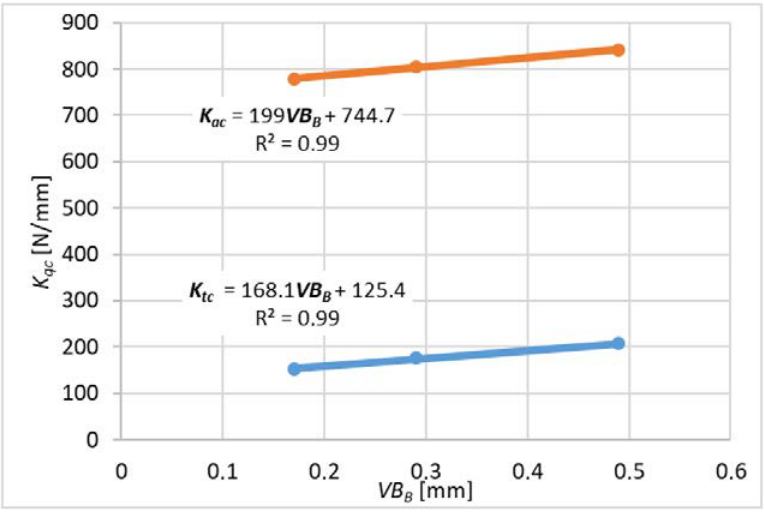
Figure 13. The influence of tool wear on the cutting force coefficient K c for plunge milling.